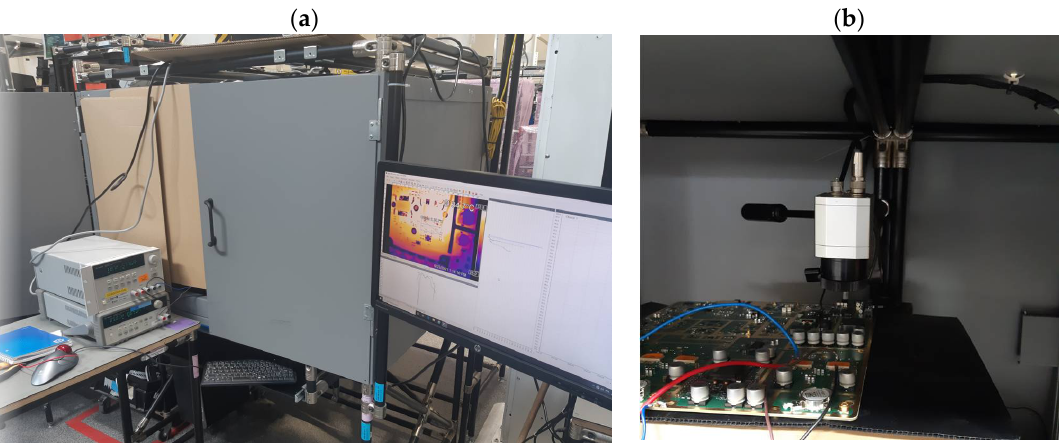
Figure 7. Set-ups for measuring thermal parameters of the BLC9G22LS-160VT transistor ( a ) and the BLC10G22LS-240PVT transistor ( b ).